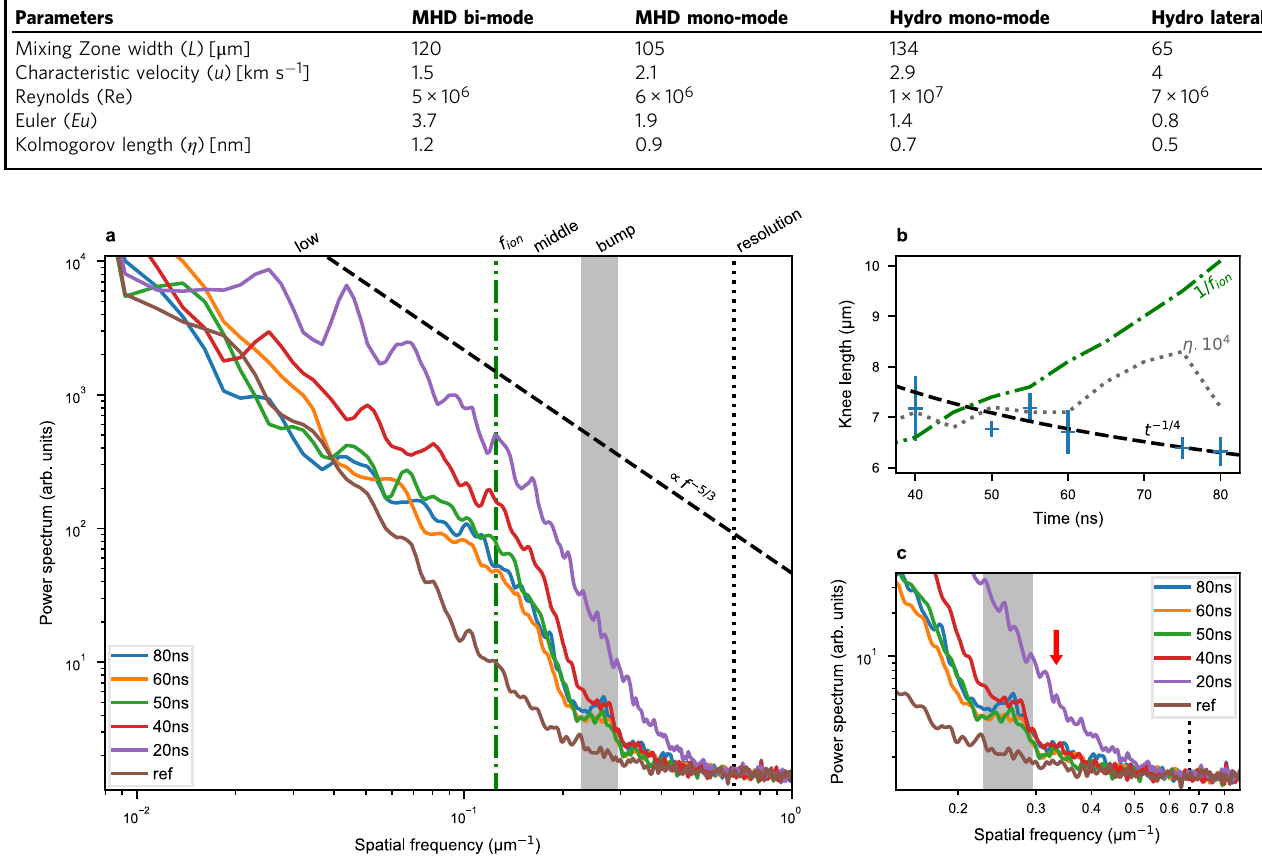
Fig. 4 Spatial power spectra of the turbulent zone. Spatial power spectrum ( a ), temporal evolution of the knee position ( b ) and bump morphology ( c ). a Typical radial power spectrum of the turbulent plasma obtained, at different times after the laser drive, compared to a reference case, non-shocked foam. The “ low ” spectrum evolved as a power law consistent with turbulence theory: a fi ducial with a − 5/3 coef fi cient is marked by dashes. The middle zone follows a power law with a much higher coef fi cient (nearly − 6.6 in the 60 ns spectrum). The spatial frequency corresponding to the ion inertial range at 50 ns, f i , is marked by the dash-dot line and is near the in fl exion of the spectrum. The bump is highlighted by the grey zone, and is abnormal considering classical turbulence theory. The nearly fl at spectrum, for spatial frequency above the bump, corresponds to the resolution limit of our diagnostic. b Evolution of the knee position as a function of time. The data points correspond to the mean values of our data set with a standard deviation as error bars. The dashed fi ducial corresponds to a t − 1/4 evolution. The dotted line corresponds to the simulated Kolmogorov scale (as calculated in Table 2 for the hydrodynamic mono-mode case) time of 10 4 . The green dash-dotted line to the theoretical ion inertial range. c Comparison of the bump morphology at different times. The greyed zone highlights the bump position. The red arrow marks the phase contrast wavelength measured on